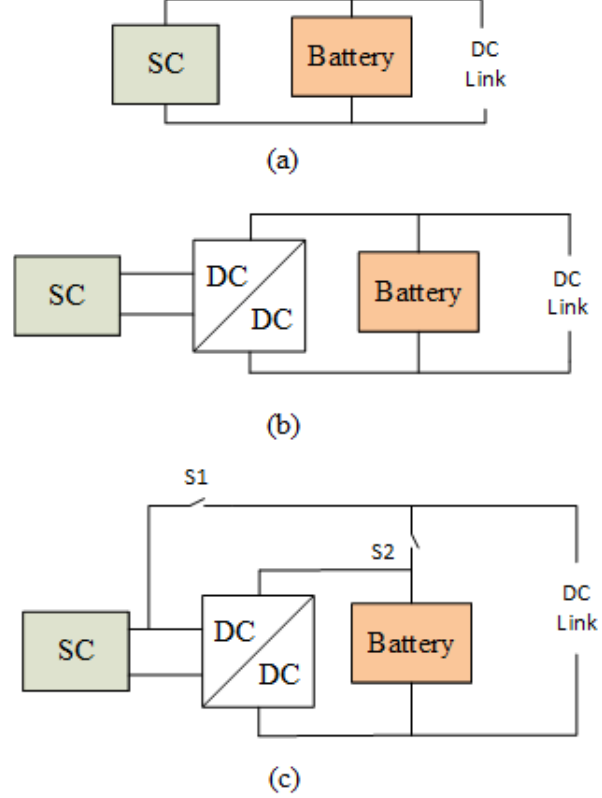
Figure 6. Clarification of SC + battery configurations used in EVs: ( a ) Passive configuration, ( b ) semi- active configuration, and ( c ) active configuration [31].